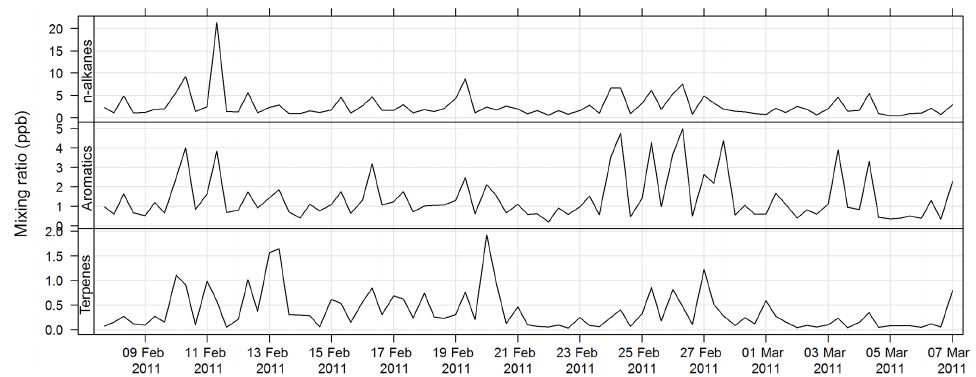
Figure 21. Time series of total alkane, total aromatics, and total terpene mixing ratios during SPS-I in 2011 measured on absorbent tubes.